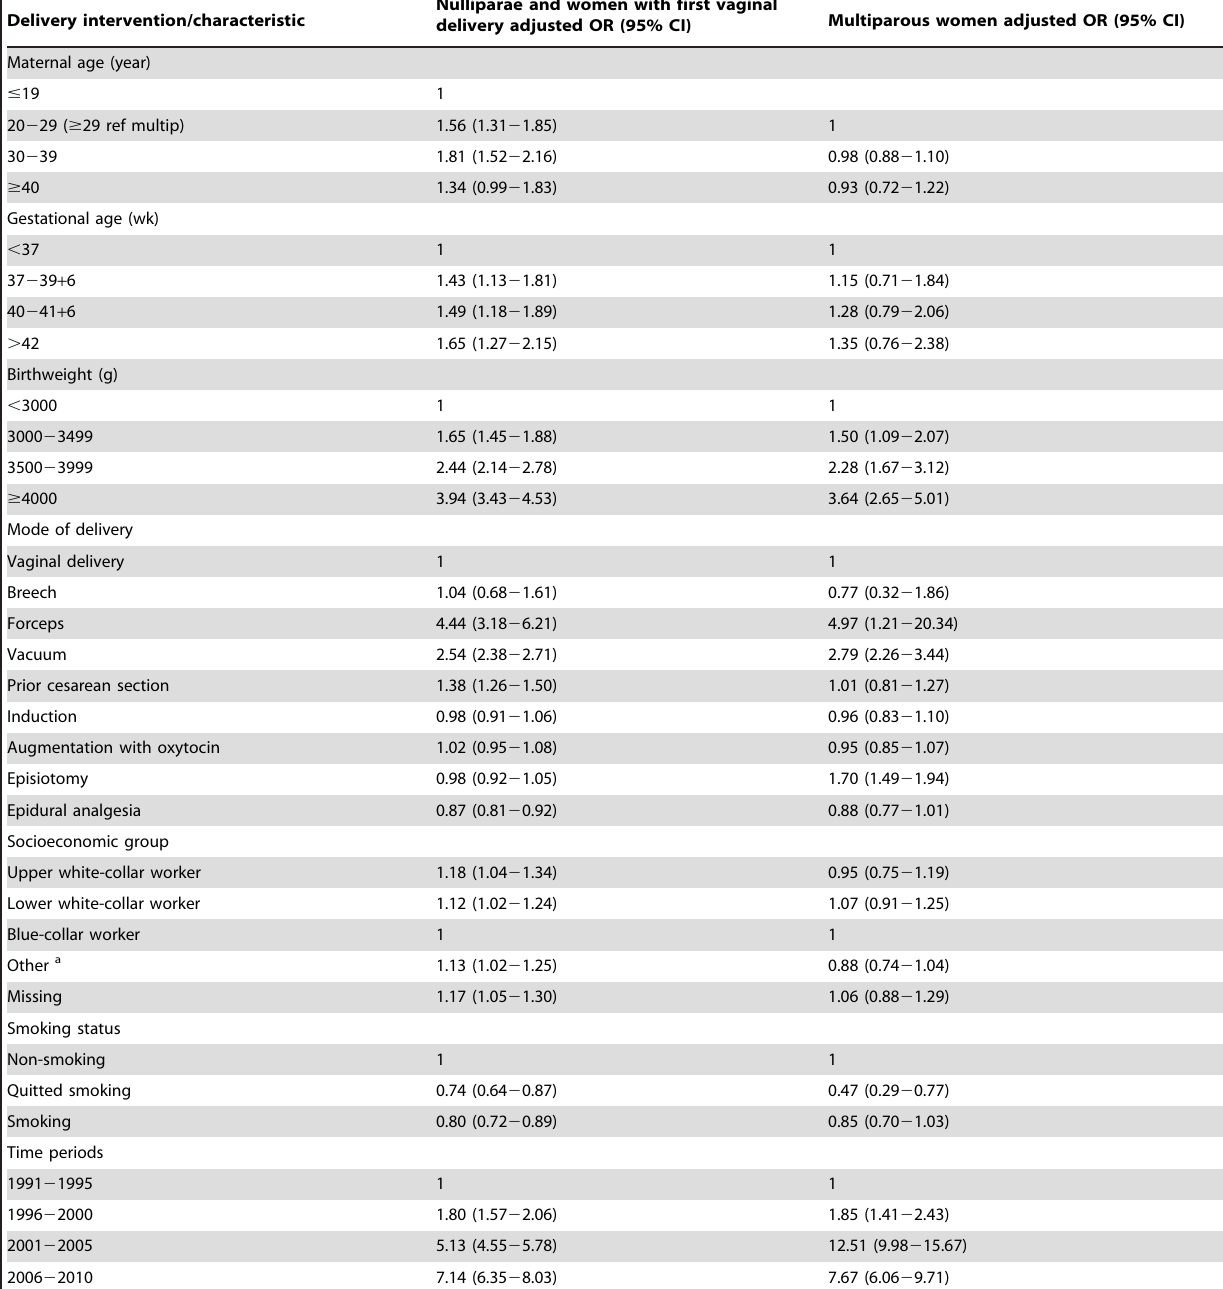
Table 3. Adjusted odds ratio (OR) of OASIS in nulliparous women including women admitted for first vaginal delivery after a prior cesarean section for their first birth (n= 408,272) and multiparous women (n=547,257) women with singleton births between 1991 and 2010 in Finland (Logistic